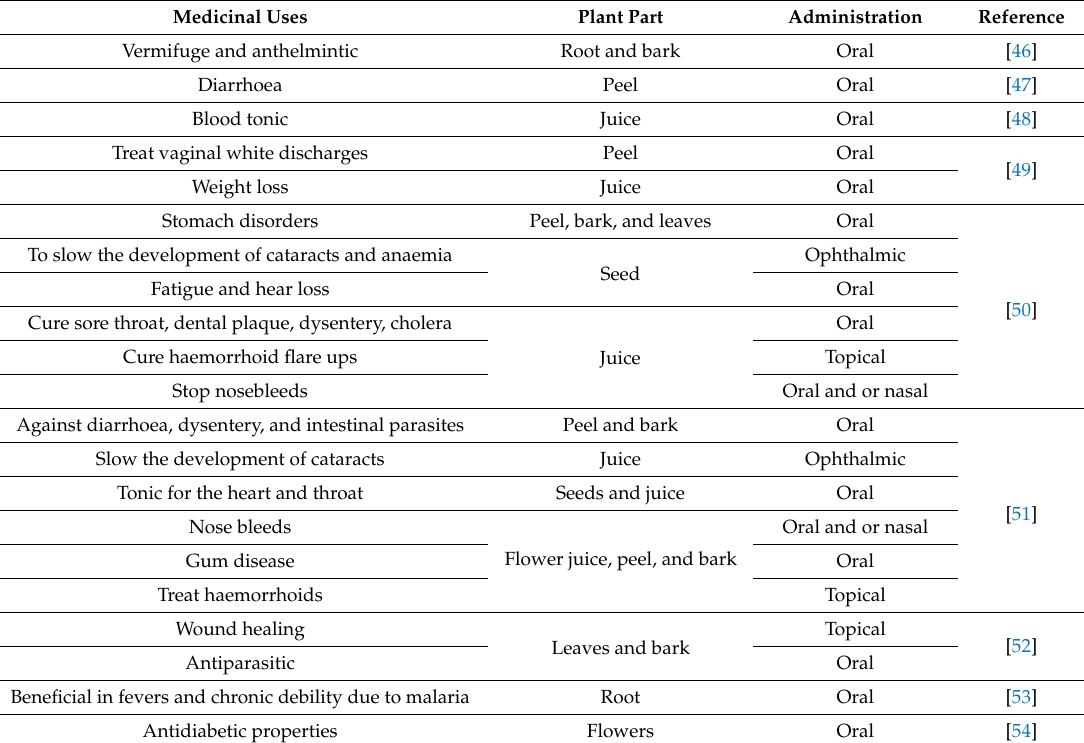
Table 1. Medicinal uses of P. granatum